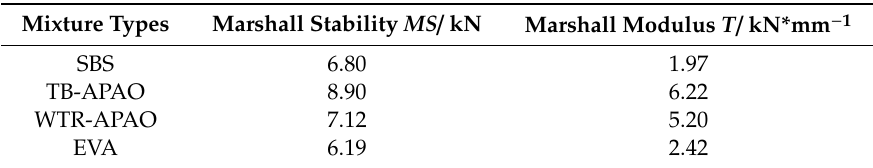
Table 4. Marshall test results of asphalt mixtures.